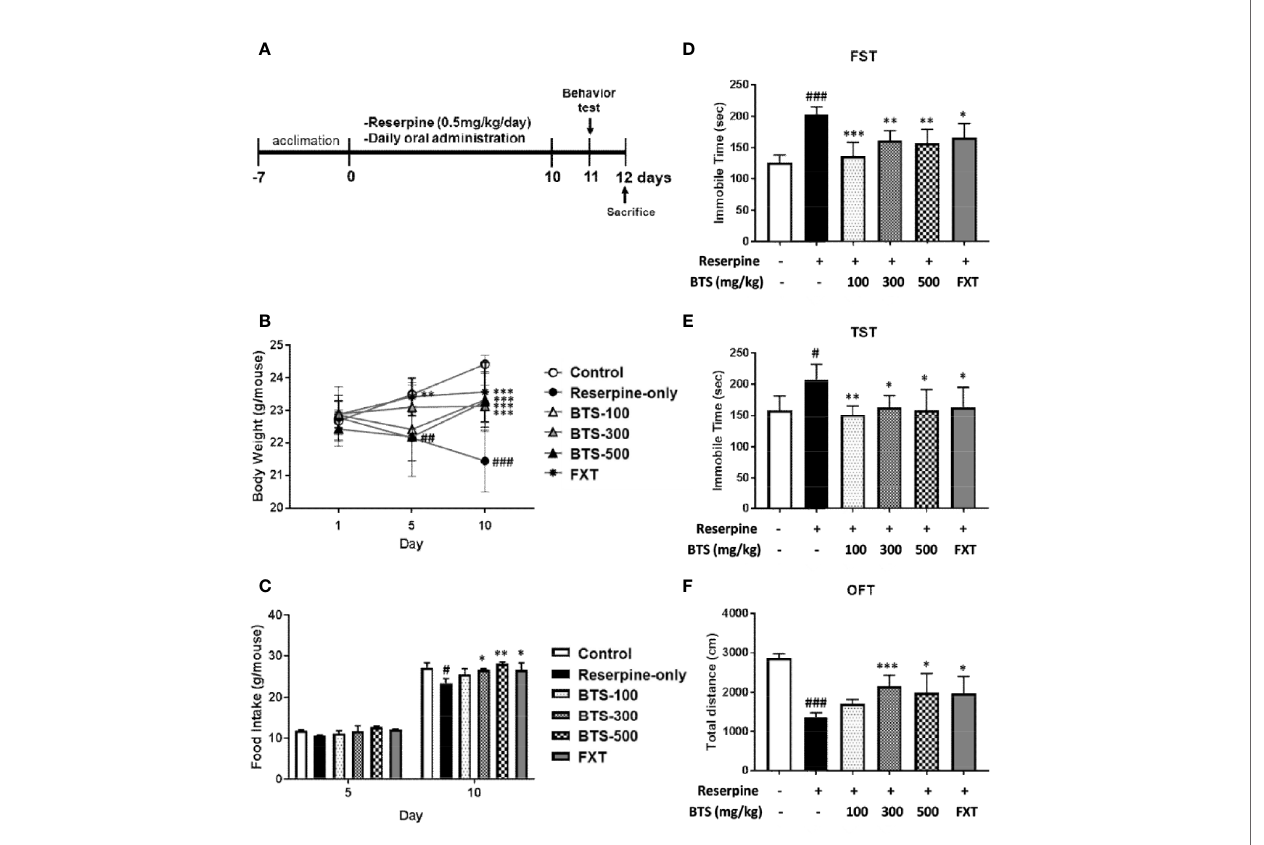
FIGURE 1 | Effects of BTS on development and depression-related behaviors of reserpine-induced depression in mice. Mice were orally administered vehicle (PBS), BTS (100, 300, or 500 mg/kg), or fl uoxetine (FXT, 20 mg/kg) for the indicated durations on a daily base. (A) Reserpine treatment and oral administration schedules for the behavior experiments. (B) Body weight and (C) food intake were measured on the indicated days. (D) Immobility time in the forced swimming test (FST) and (E) the tail suspension test (TST) and (F) total travel distance in the open fi eld test (OFT), measured on day 11. Data are mean ± SD values (n = 6, one-way ANOVA: # p < 0.05, ## p < 0.01, ### p < 0.001 vs. control; *p < 0.05, **p < 0.01, ***p < 0.001 vs.